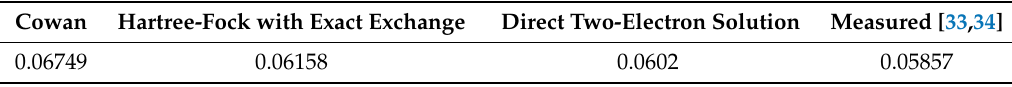
Table 2. Energy difference between 2 s 3 S and 2 s 1 S in